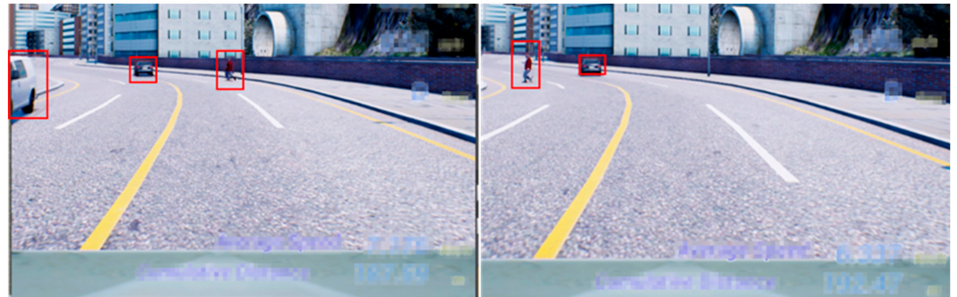
Figure 16. Execution in the custom event mode.